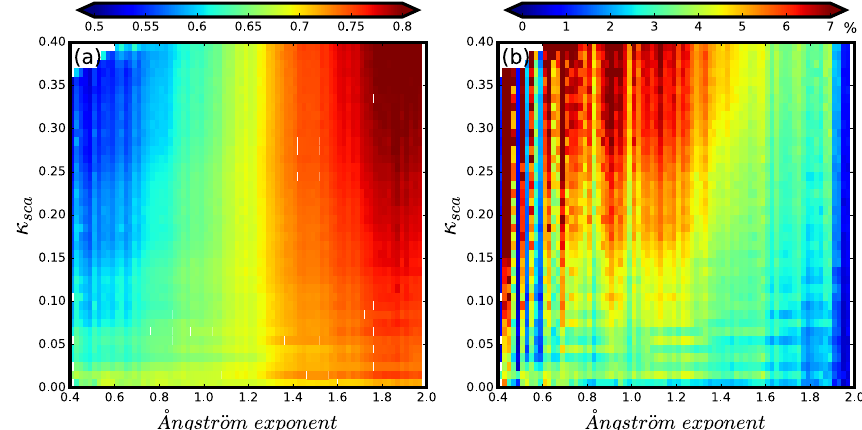
Figure 6. (a) Colors represent R κ values and the color bar is shown at the top of this figure. The x axis represents the Ångström exponent and the y axis represents κ sca . (b) Meanings of x axis and y axis are the same as in (a) ; however, color represents the percentile value of the standard deviation of R κ values within each grid divided by their